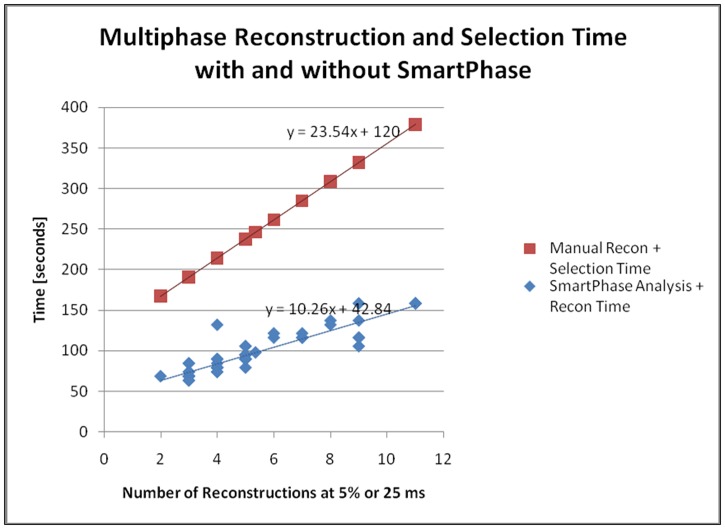
Comparison of the numbers of reconstructions and time by MS and SP algorithms.MS = Manual Selection, SP = Smart Phase.